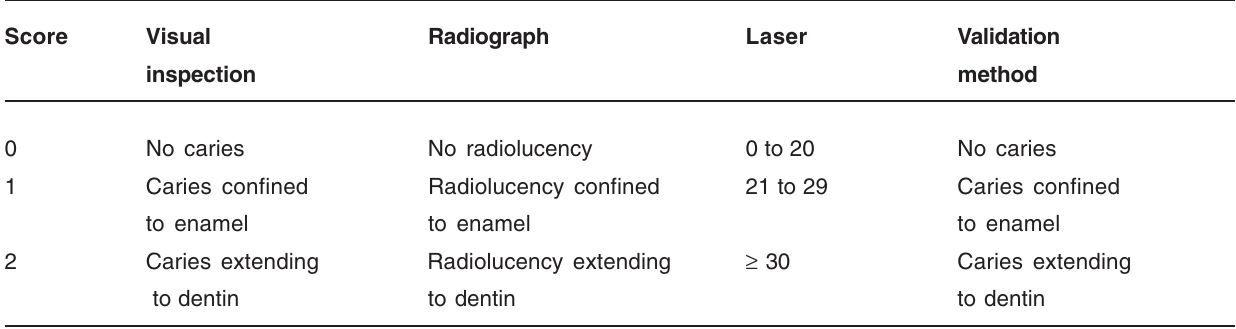
TABLE 2- Comparison of DIAGNOdent’s scores for the excluded teeth, opened teeth and sound teeth